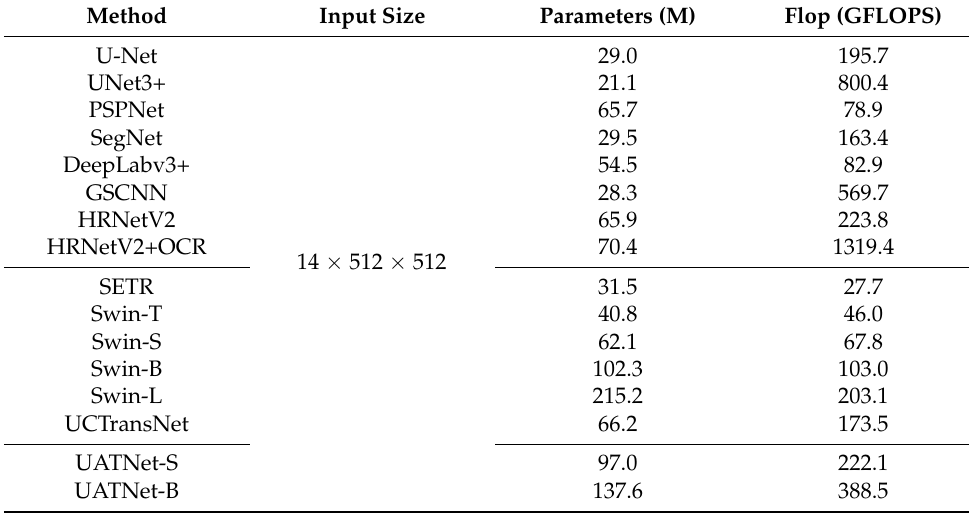
Table 13. Computational complexity on